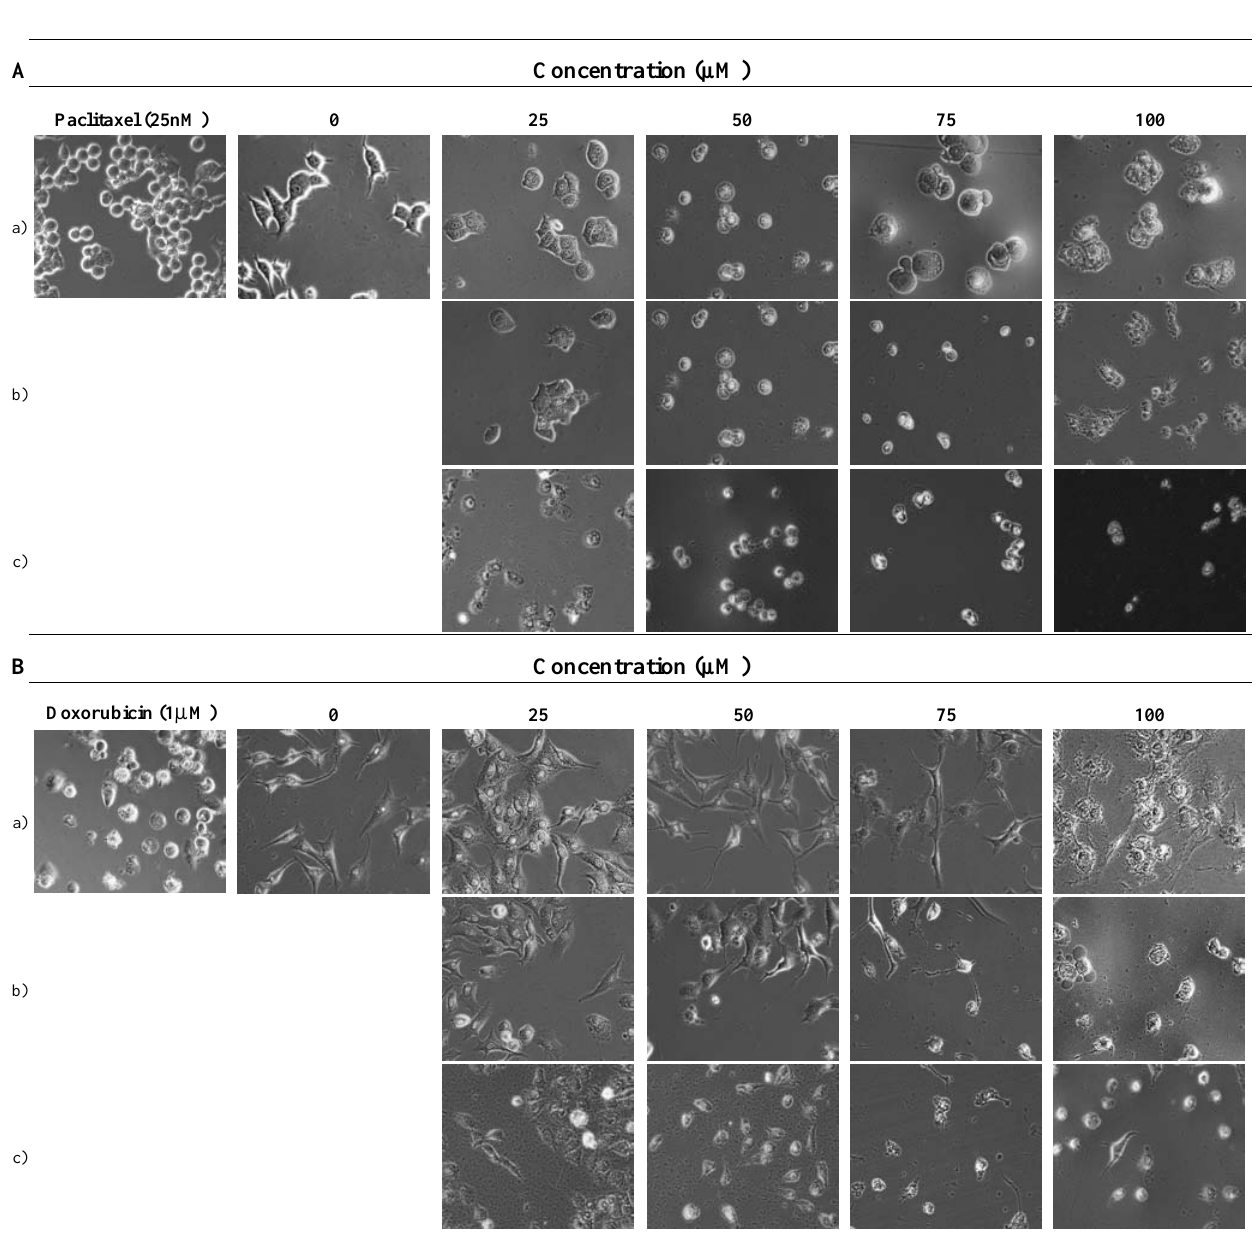
Figure 3. 9'- O -methylvibsanol (3) induced apoptosis in MCF-7, A549 cells. Morphological change of (A)MCF-7, (B)A549 cells observed under an inverted phase contrast microscope (400